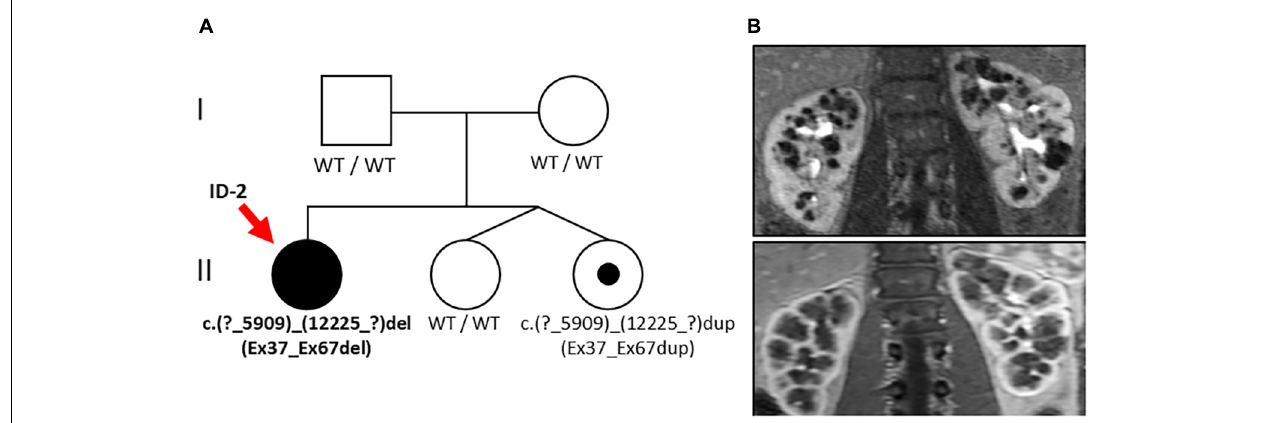
FIGURE 2 | Pedigree and renal imaging (Family 2). (A) Family pedigree: Individuals suffering from PKD are indicated as black symbols and variant carriers with a black dot. Genetic analysis in the index patient (ID-2, red arrow) revealed the large heterozygous deletion NM_138694.3: c.(?_5909)_(12225_?)del of PKHD1 (Ex37_Ex67del) and familial segregation analysis in one younger sibling yielded duplication of the same alteration c.(?_5909)_(12225_?)dup (Ex37_Ex67dup). (B) Abdominal MRI of ID 2 at the age of 18 years showing bilateral cystic kidney enlargement.